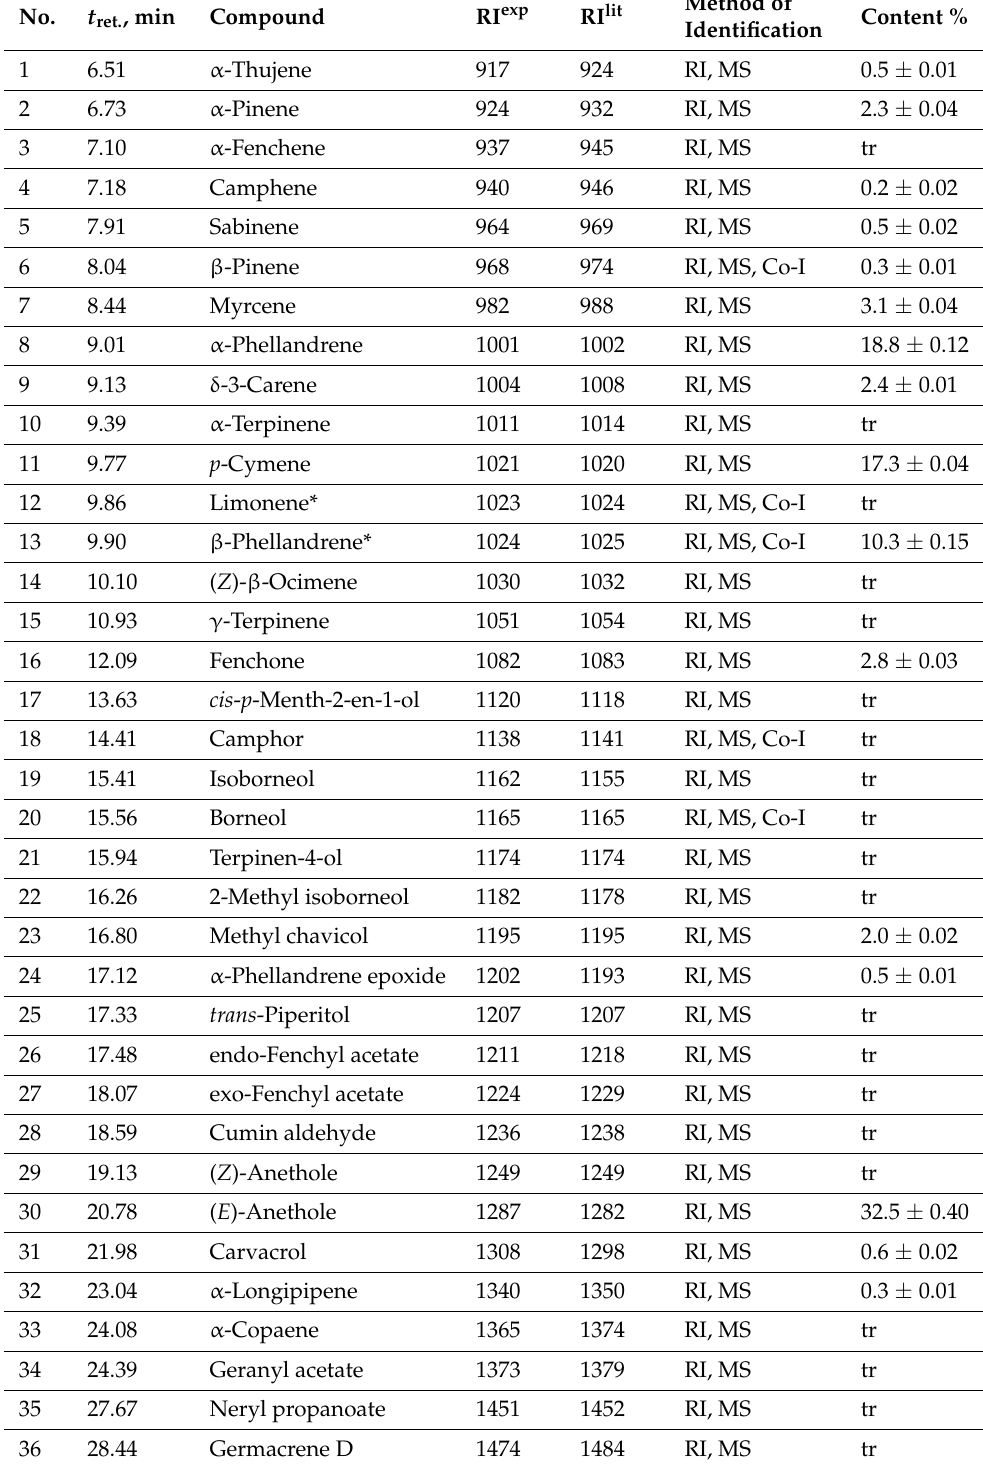
Table 3. Chemical composition of essential oil isolated from wild fennel